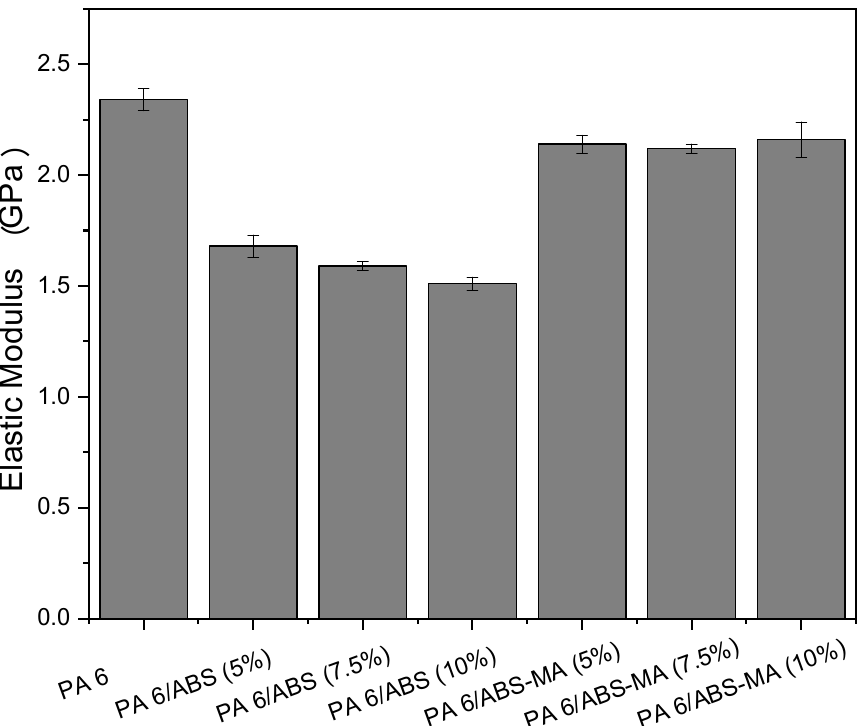
Figure 9. Tensile modulus of elasticity of PA6 and its binary blends.